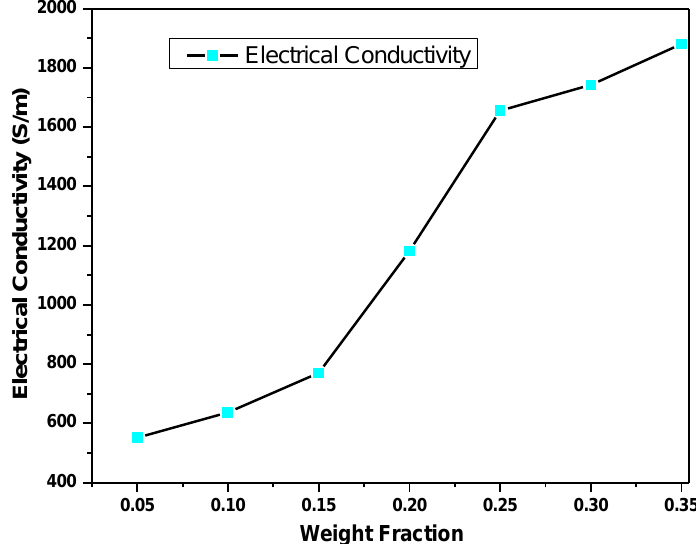
Figure 9. The experimental electrical conductivity of the HGPPy.CB 20% .